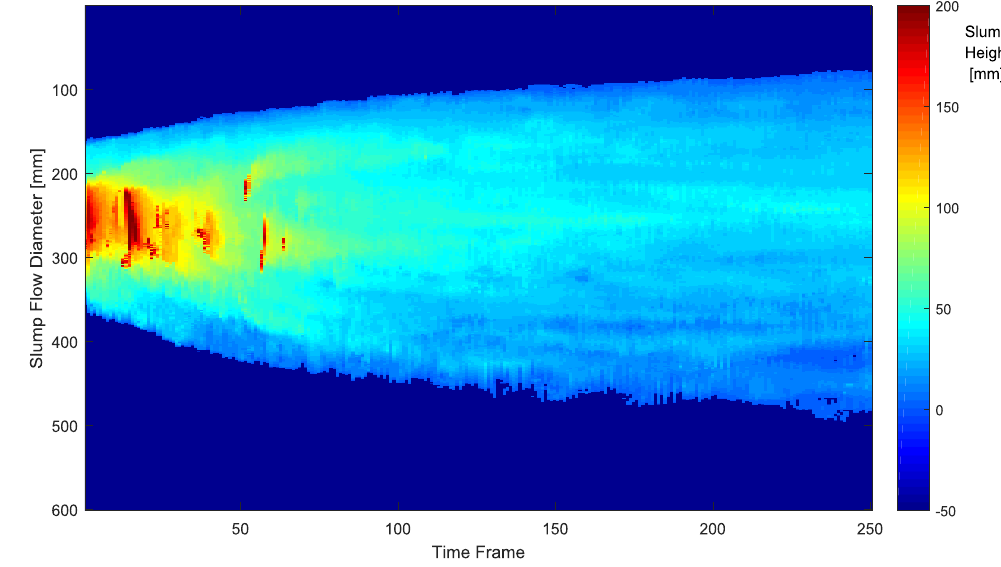
Figure 14. 4D slump image (2D color image representation).